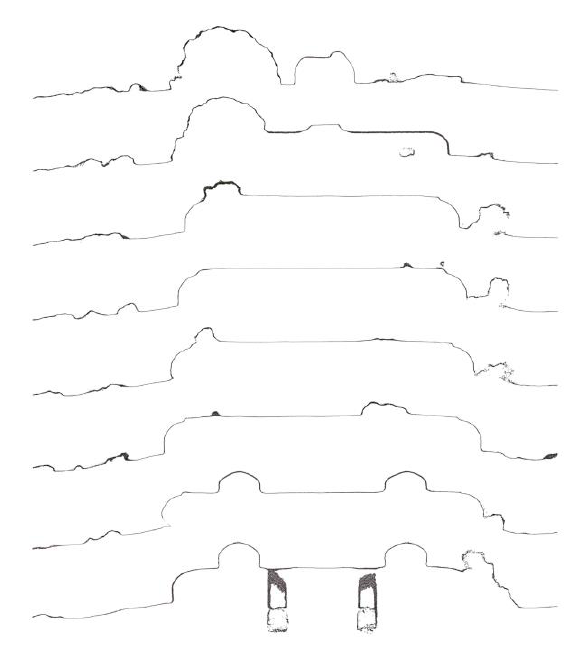
Figure 9. Vertical sections explaining complexity (drawings: